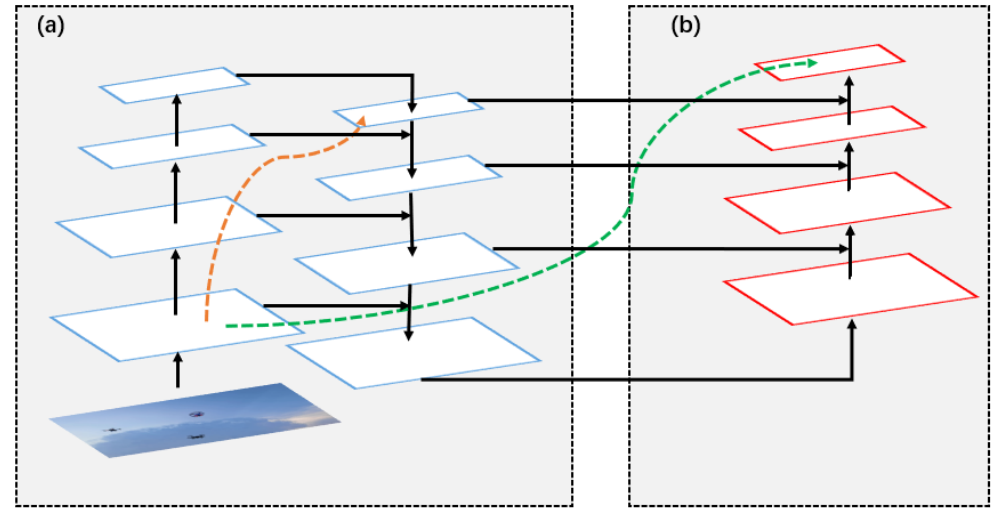
Figure 6. The structure of the original PANet.